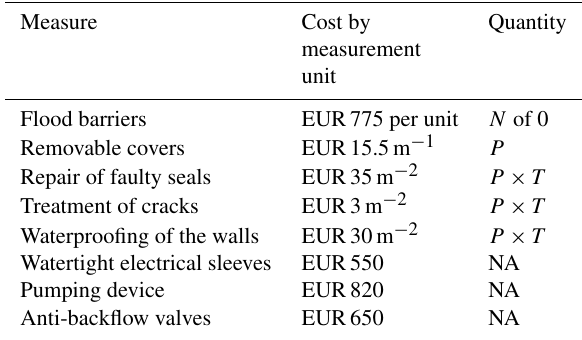
Table 4. Costs of elevating a masonry dwelling as reported by FEMA (2009).